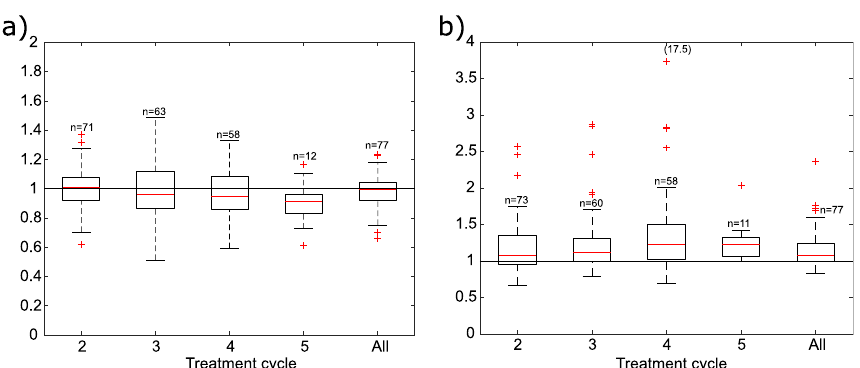
Fig. 2 Normalized absorbed doses to kidneys ( a) and tumors ( b) calculated with administered activities and dose-per-activity values from the first treatment cycle. Absorbed doses are normalized to the “true” absorbed doses, n corresponds to number of data points included in the calculation for the corresponding treatment cycle. “All” refers to the total absorbed dose from all treatment cycles. A value of 17.5 for cycle 4 was